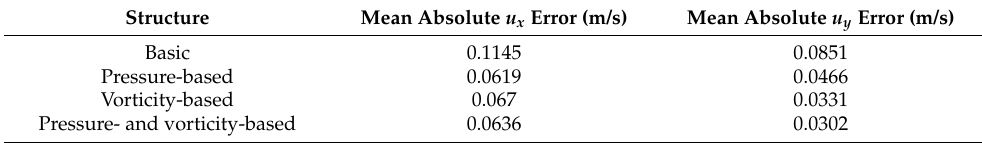
Table 3. Mean absolute error of the velocity fields predicted by the tested